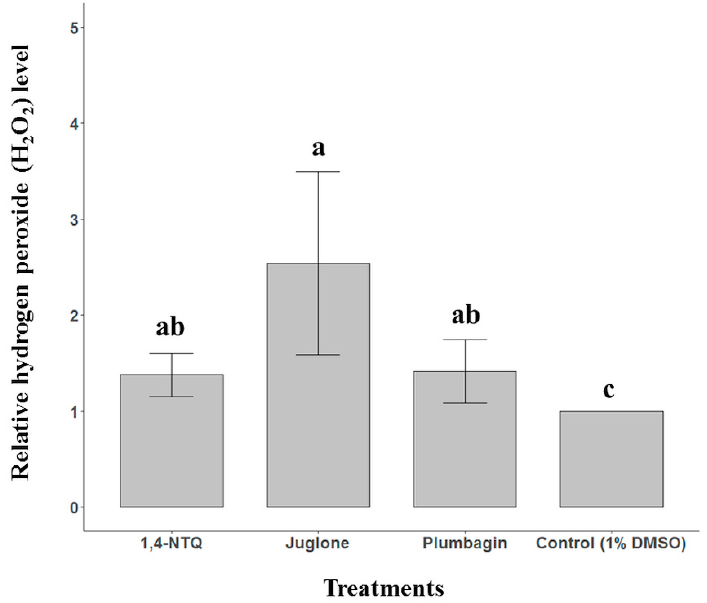
Figure 3. Measurement of H 2 O 2 levels in Bursaphelenchus xylophilus treated with three naphthoquinones in vitro. The differences in letters above the bars represent significantly different statistical values at p < 0.05 (Tukey’s test).